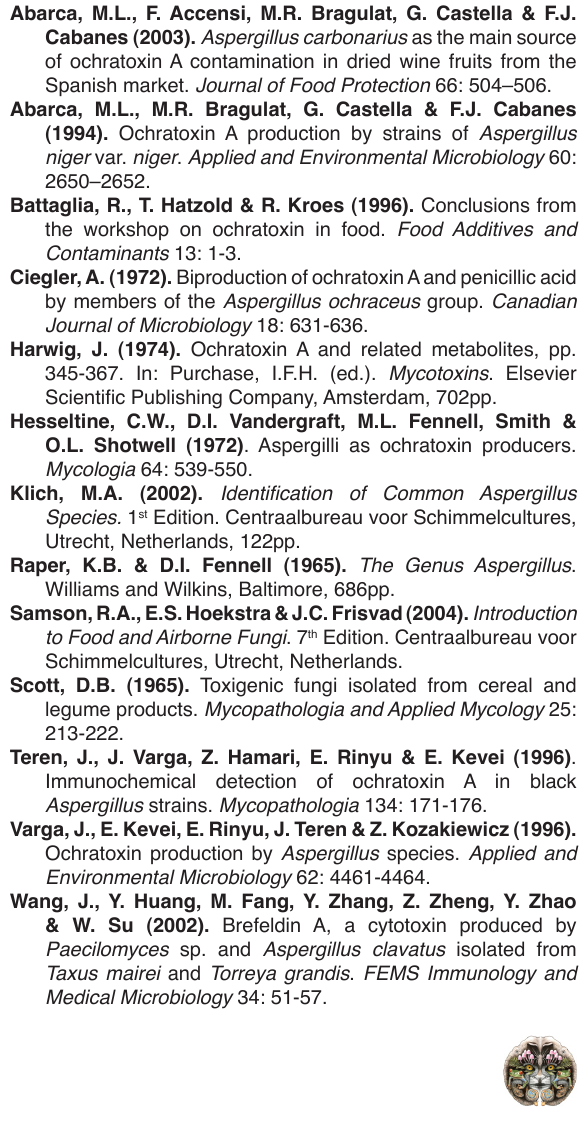
Table 1. List of Aspergillus strains examined for ochratoxin metabolite in this study